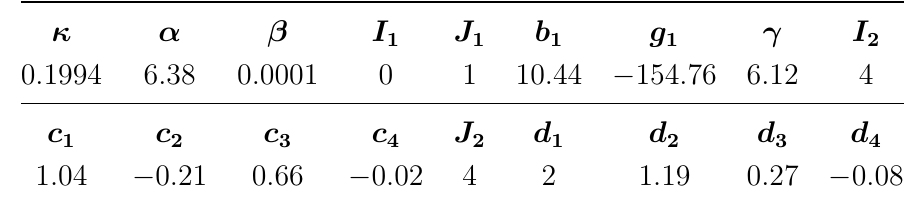
Table 1. Fitted parameters in the model of Benth and Šaltyt˙e Benth [10], for daily average temperature observations (measured in degrees Celsius) for Stockholm, Sweden, in the period January 1, 1961 until May 25,